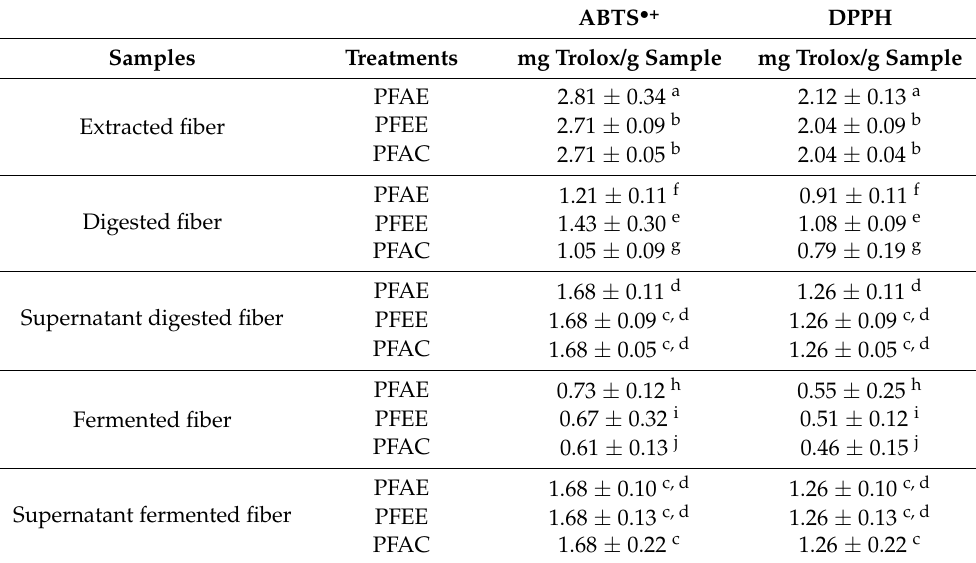
Table 2. Effect of in vitro gastrointestinal digestion and probiotic fermentation processes in the antioxidant activity of persimmon fiber by colorimetric ABTS • + and DPPH radical scavenging assays. ABTS •